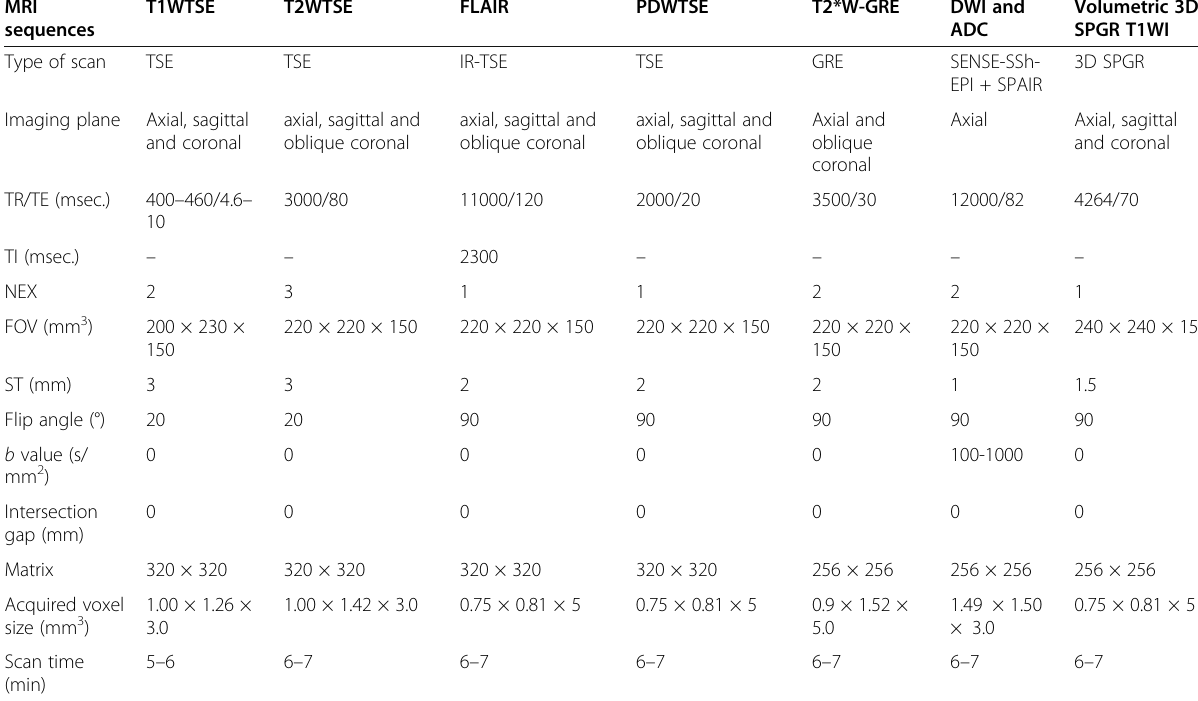
Table 1 Parameters of the used MRI sequences of the studied patients ( n = 26) MRI T1WTSE T2WTSE FLAIR PDWTSE T2*W-GRE DWI and Volumetric 3D sequences ADC SPGR T1WI Type of scan TSE TSE IR-TSE TSE GRE SENSE-SSh- 3D SPGR EPI + SPAIR Imaging plane Axial, sagittal axial, sagittal and axial, sagittal and axial, sagittal and Axial and Axial Axial, sagittal and coronal oblique coronal oblique coronal oblique coronal oblique and coronal coronal TR/TE (msec.) 400 – 460/4.6 –